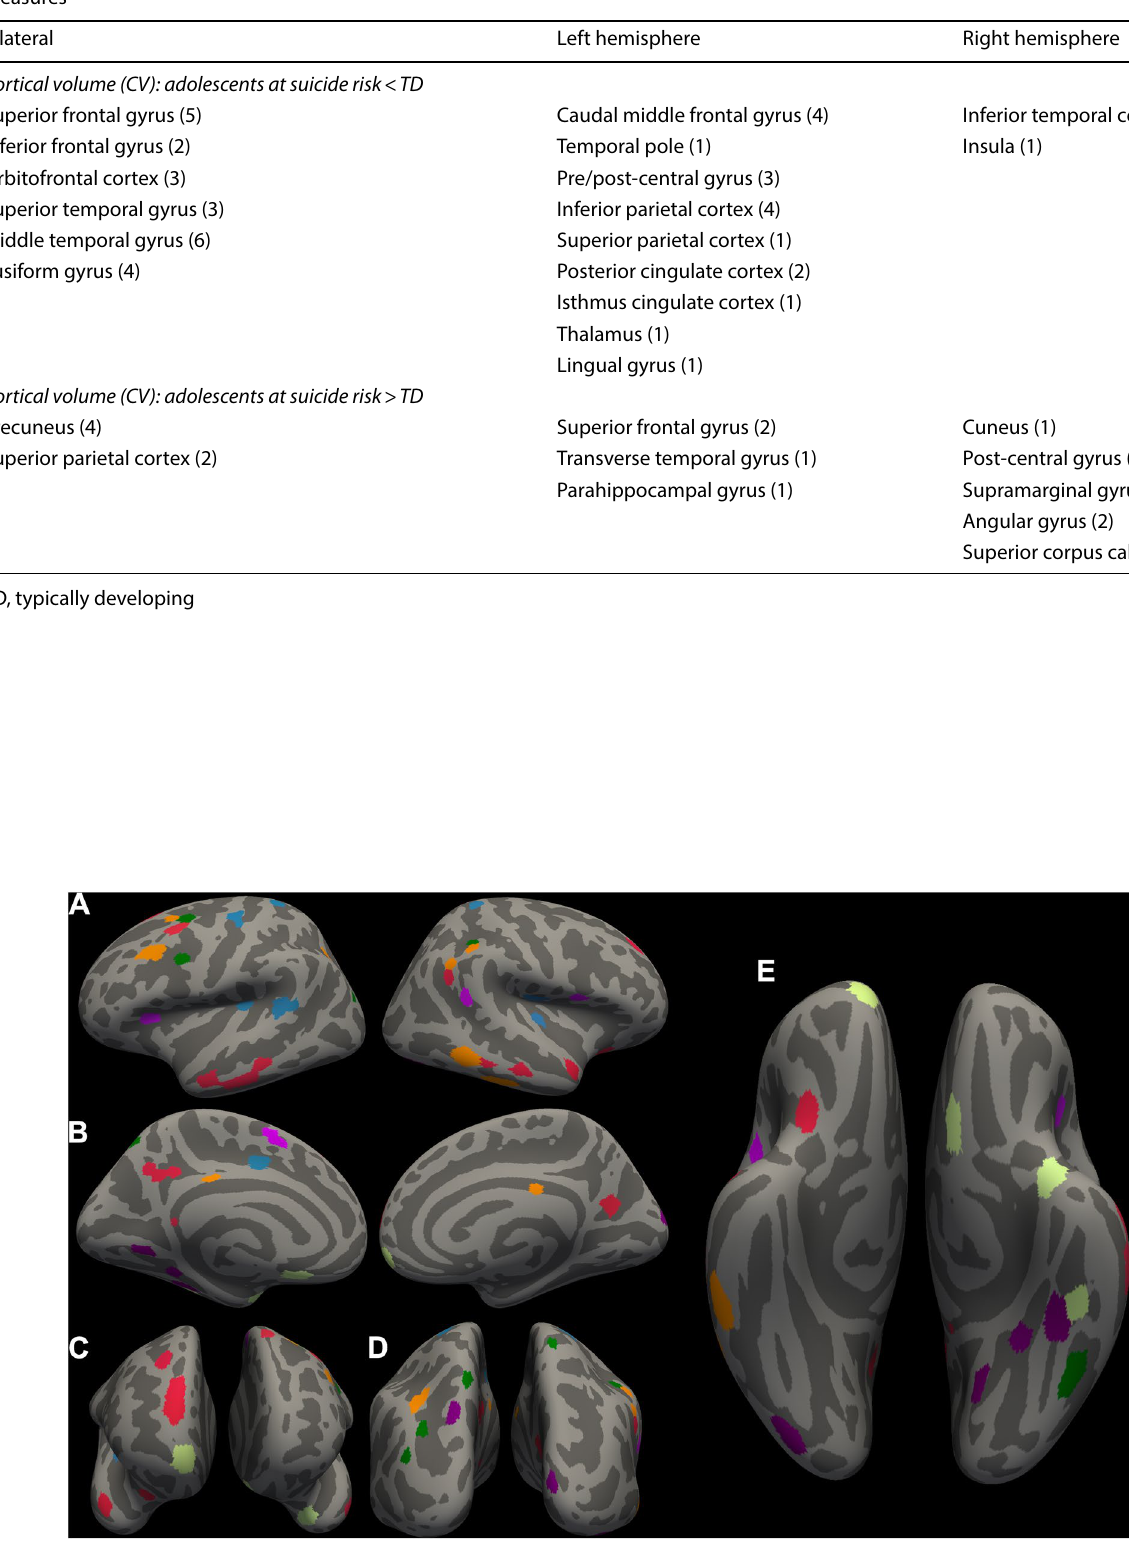
Table 2 Laterality, morphometry measures, direction, and regions (number of features) associated with machine learning performance measures